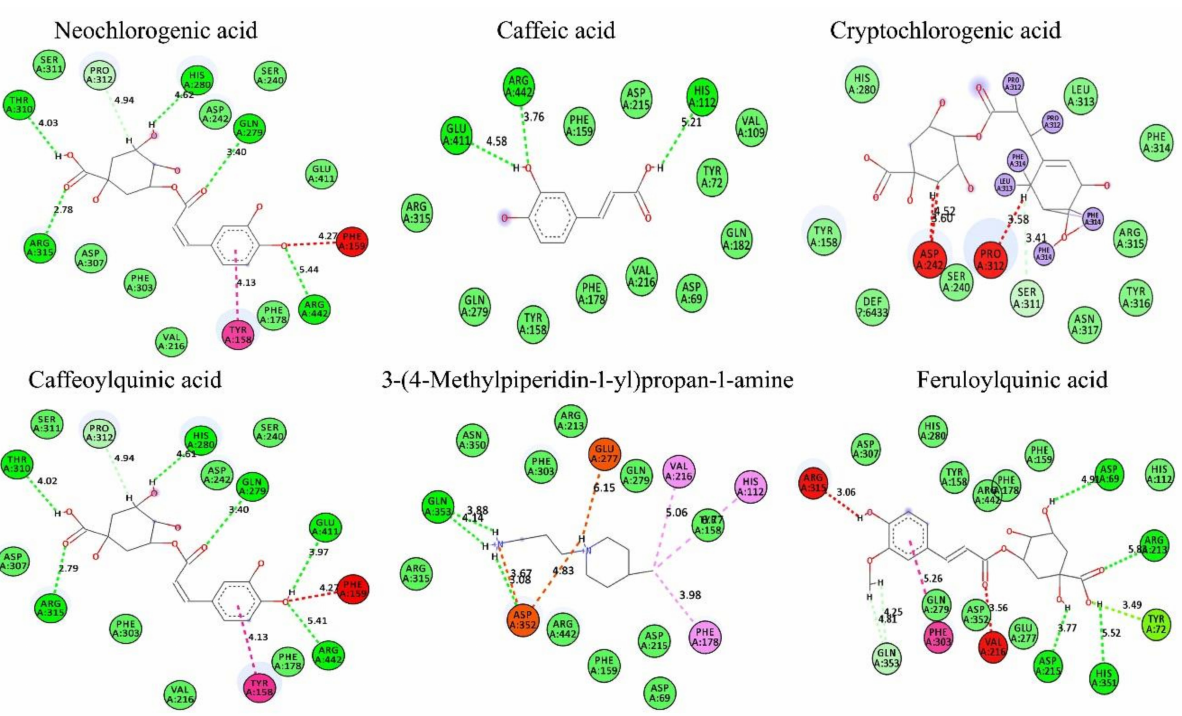
Figure 7. In silico docking analysis of isolated compounds from Ht-EAE with anti-diabetic target molecule of α -glucosidase. Based on the hydrogen bonding ability and docking score, it can be concluded that cryptochlorogenic acid showed a superior binding affinity toward the binding molecule of α -amylase and caffeoylquinic acid against α -glycosidase. In the α -amylase docking assay, the docking score of cryptochlorogenic acid was found to be − 9.86082 and it forms hydrogen bonds with amino acids, such as Glu318, Gly283, and Pro34, present in the active site, at a distance of 5.23 Å, 4.22 Å and 4.43 Å, respectively. Similarly, caffeoylquinic acid showed the highest binding score ( − 10.7379 kcal/mol) with α -glycosidase. It was found to form hydrogen bonds with amino acids of Arg442, Glu411, Gln279, His280, Thr310, and Arg315, present in the active site, at a distance of 5.41 Å, 3.97 Å, 3.40 Å, 4.61 Å, 4.02 Å,